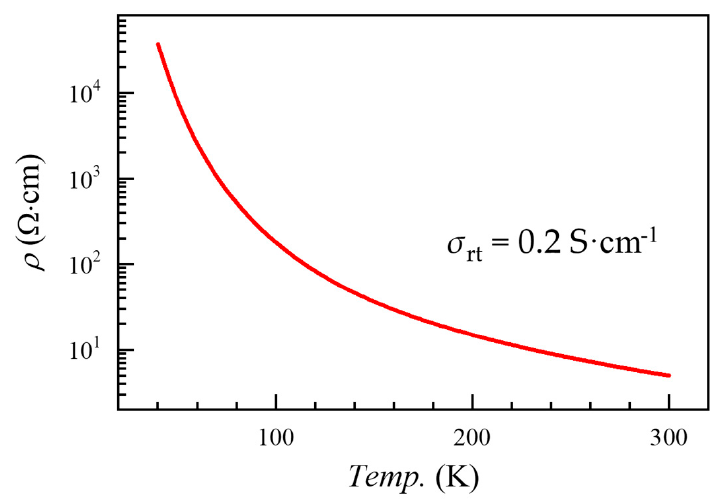
Figure 3. Temperature dependence of electrical resistivity of 2 measured by using compressed pellets.